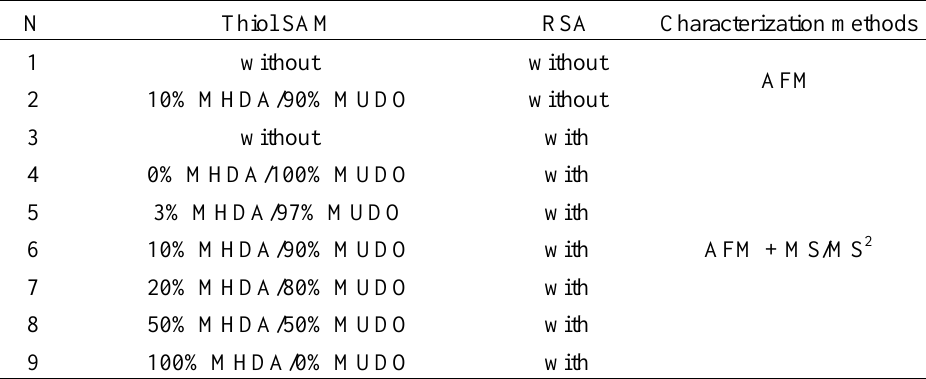
Table 2 . Different chemical interfaces tested on the GaAs surface with or without RSA grafting. N Thiol SAM RSA Characterization